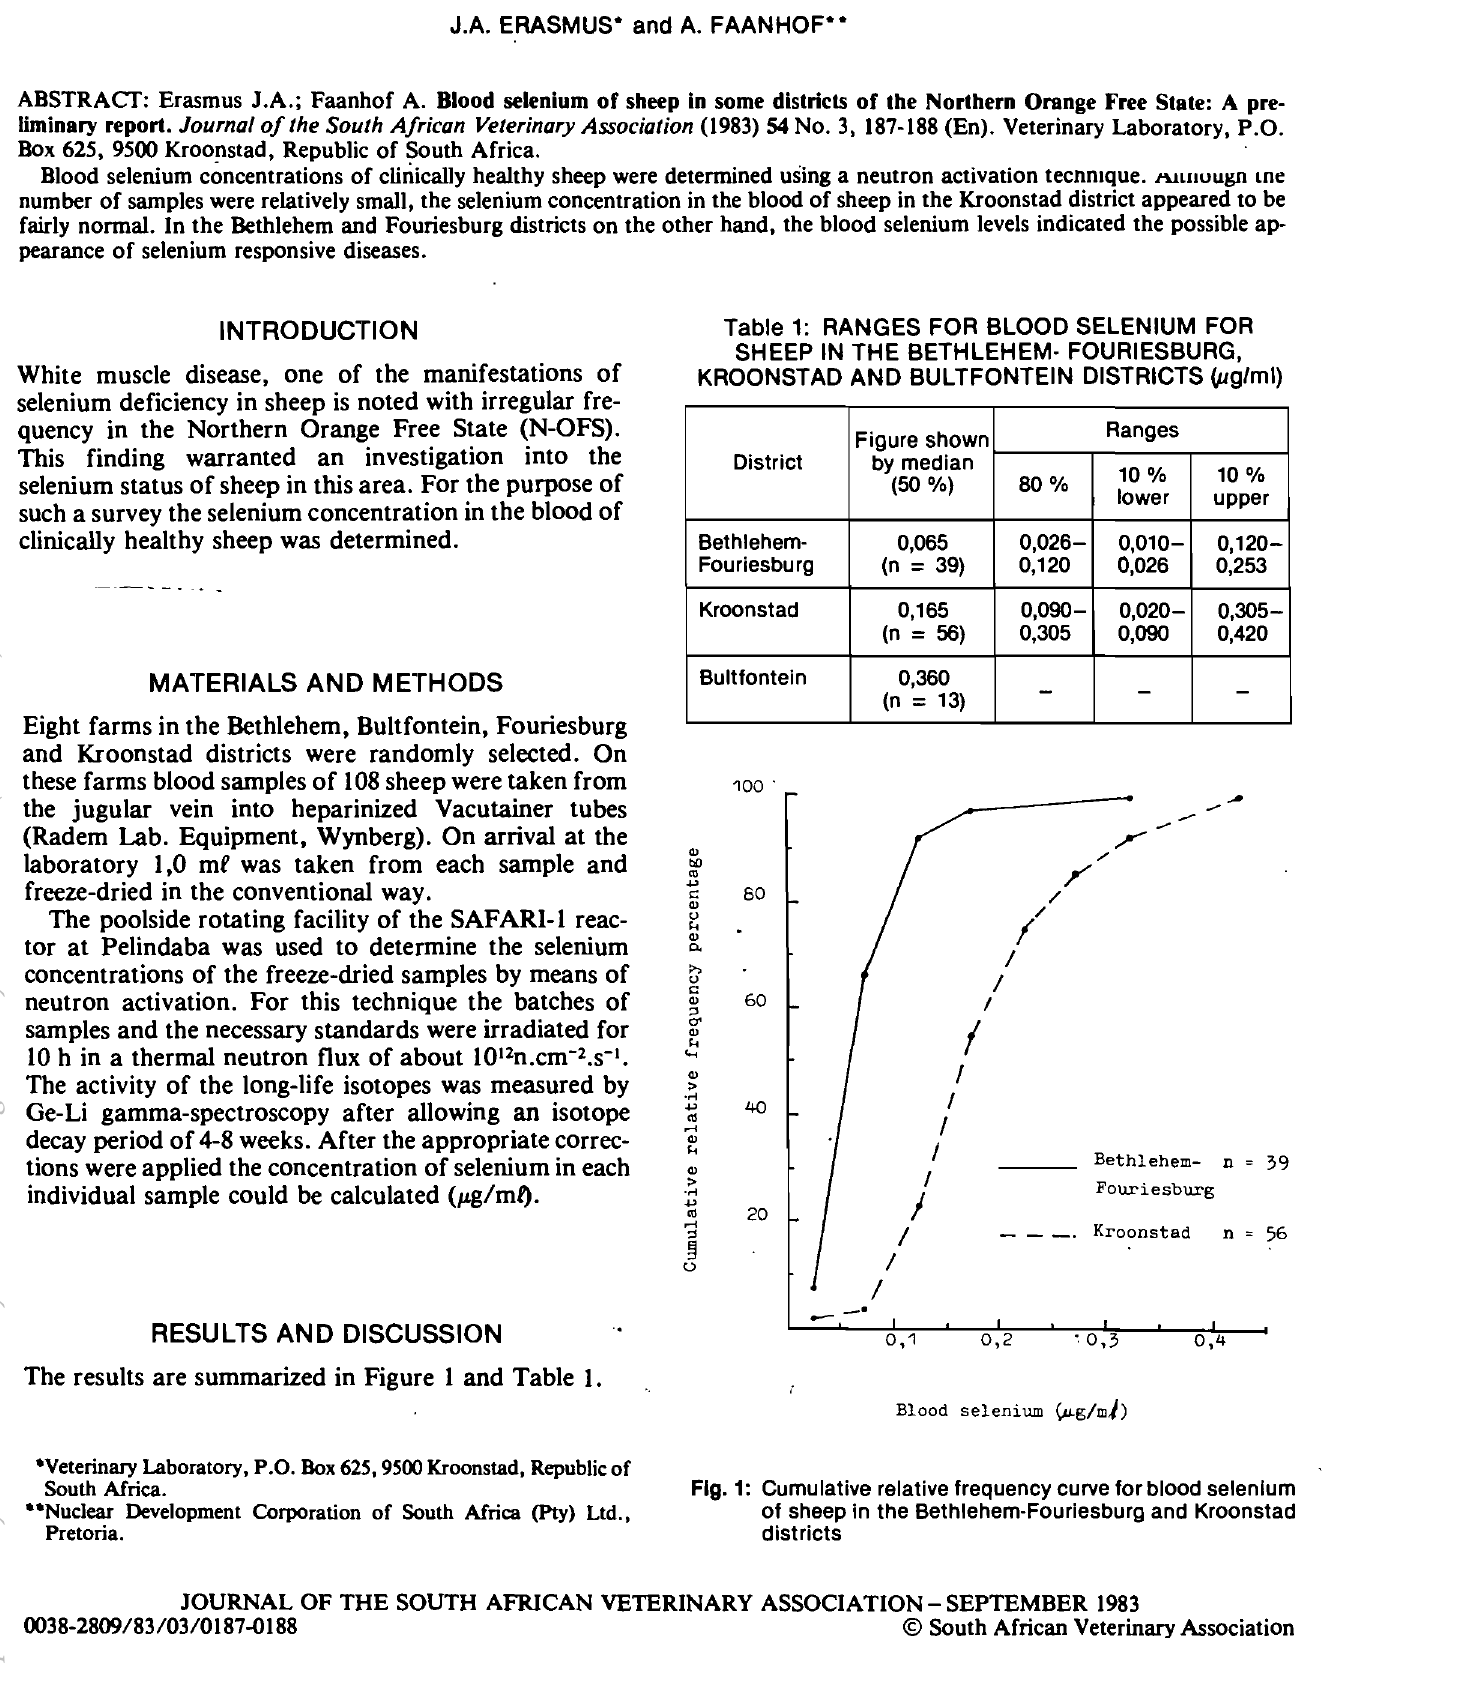
Fig. 1: Cumulative relative frequency curve for blood selenium of sheep in the Bethlehem-Fouriesburg and Kroonstad